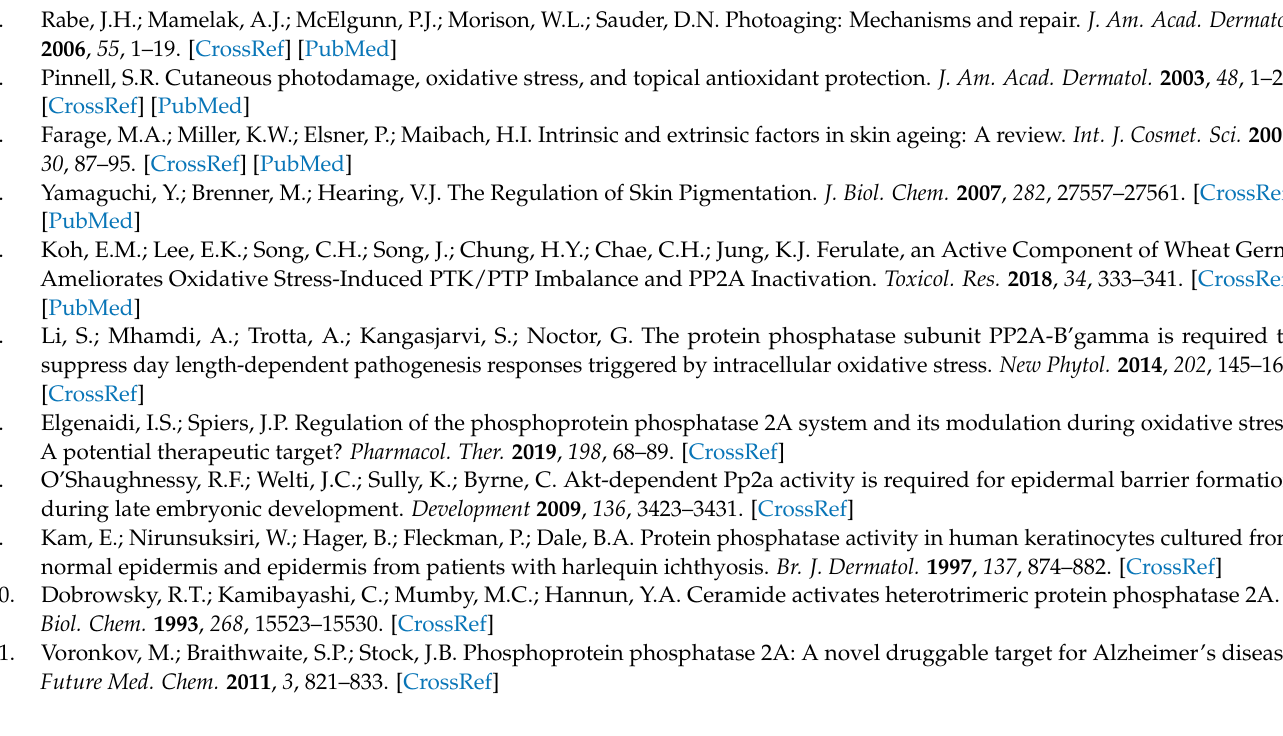
temperatures, Figure S2: Arbutin control in tyrosinase enzyme activity assay, Figure S3: Cell viability of test materials in culture, Table S1: Clinical study